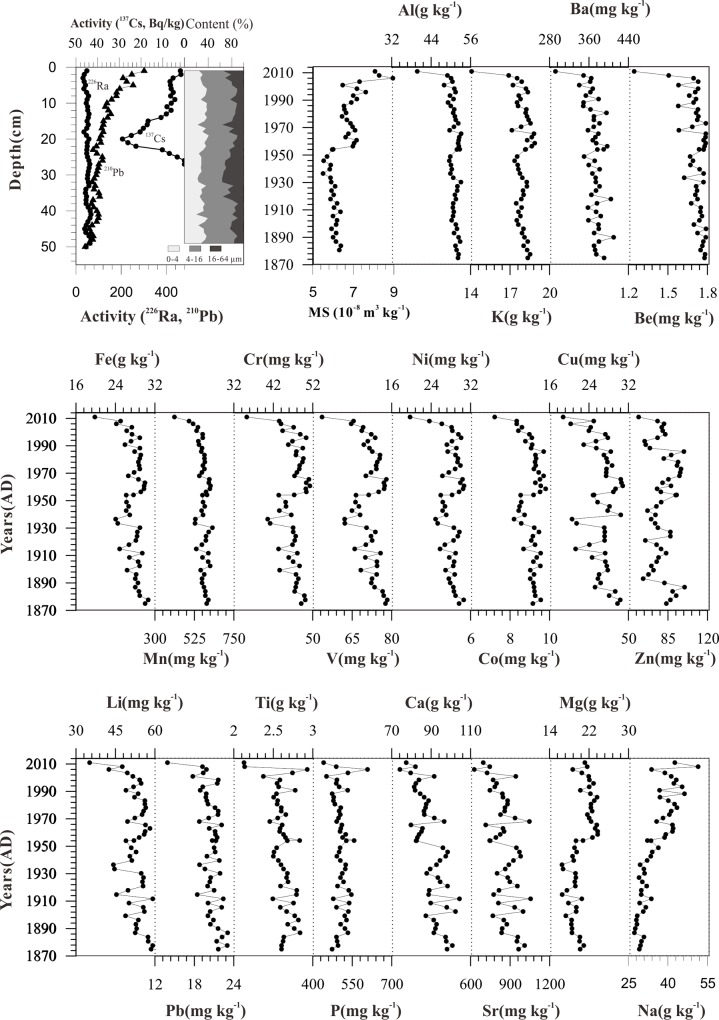
The specific activity of 137Cs, 226Ra and total 210Pb activity in Ebinur Lake core sediment and the profiles for elemental concentrations in Ebinur Lake core sediment.